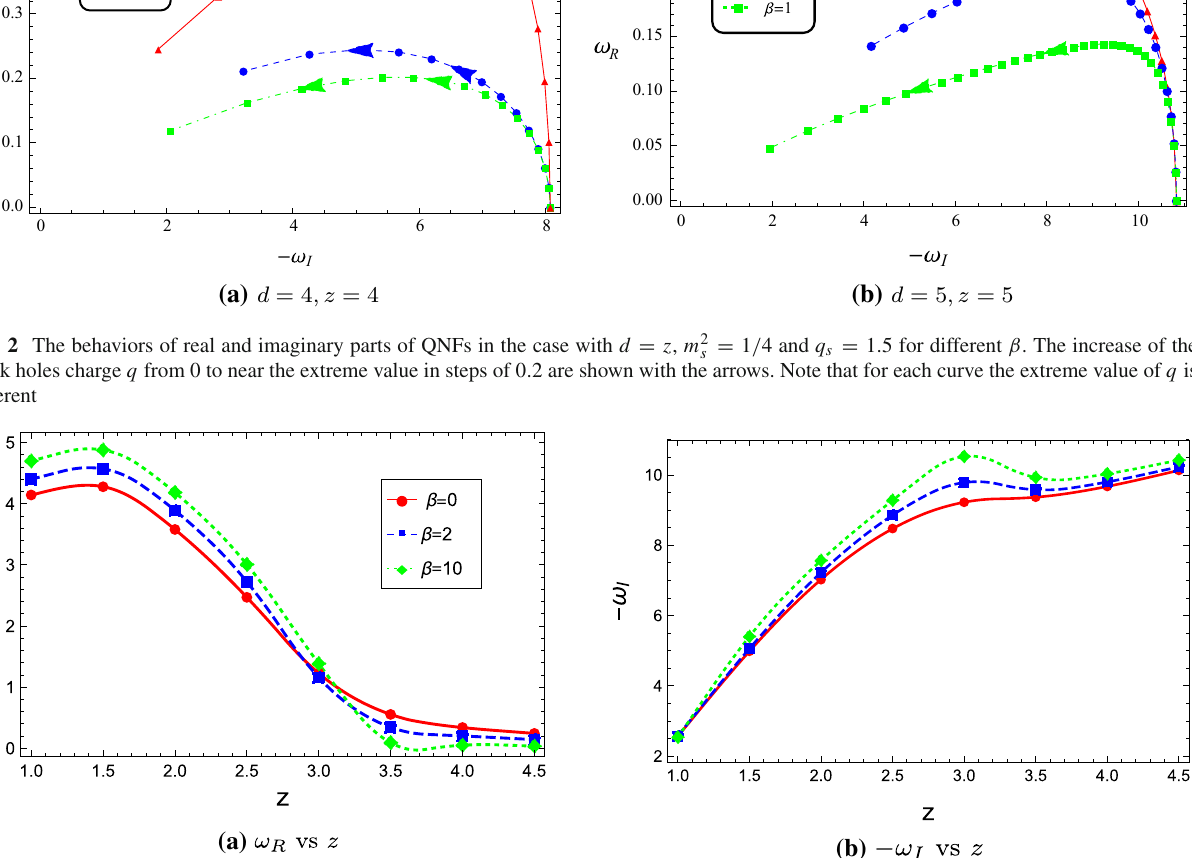
z . For small values of Lifshitz exponent, ω R increases as β increases whereas for large z , ω R is lower for higher values of β . Furthermore, ω R reduces as z becomes big and finally flattens. The value of ω R for high z can approach to zero.